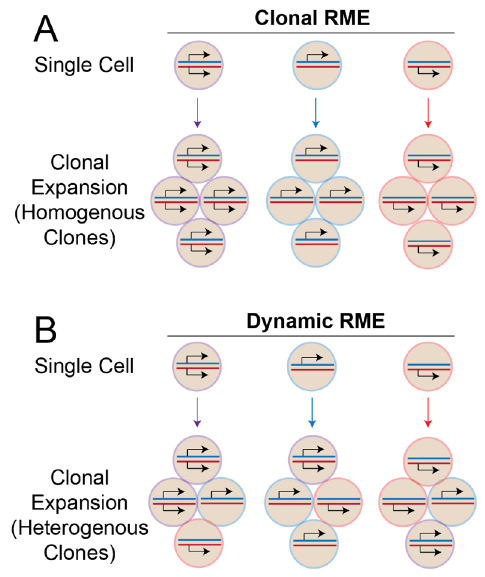
Figure 2. Schematic depiction of clonal versus dynamic random monoallelic expression (RME). ( A ) Clonal RME is identified when a single cell is expanded to form a colony of daughter cells and each daughter cell has the same allele expression pattern as the original parent cell. Typically, studies of this phenomenon use cell lines and expand them clonally and then profile allelic expression from the entire batch of cells in the clone. They find that some clones exclusively express one allele, others are biallelic, and others express only the other allele (homogenous clones). ( B ) Dynamic RME occurs when a single cell is expanded to form a colony but the individual cells in the colony have different allelic expression patterns (heterogeneous clones). This phenomenon is detectable only by using single-cell transcriptome analysis and cannot be identified from profiles of the whole batch of cells in the clone, as was done in previous cell line studies reporting widespread clonal